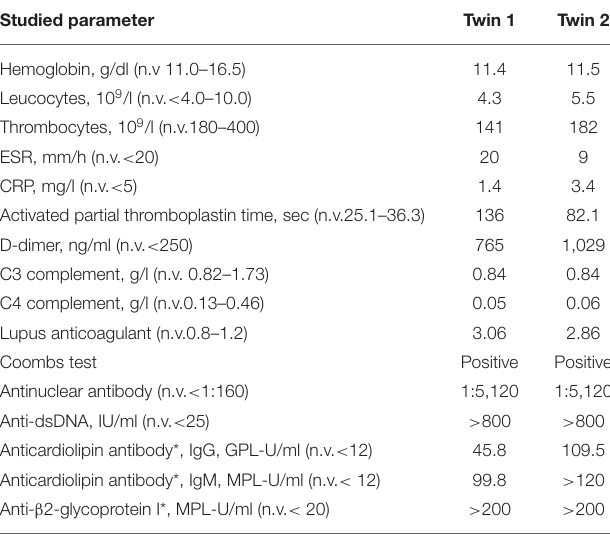
TABLE 1 | Laboratory characteristics of patients at the disease onset. Studied